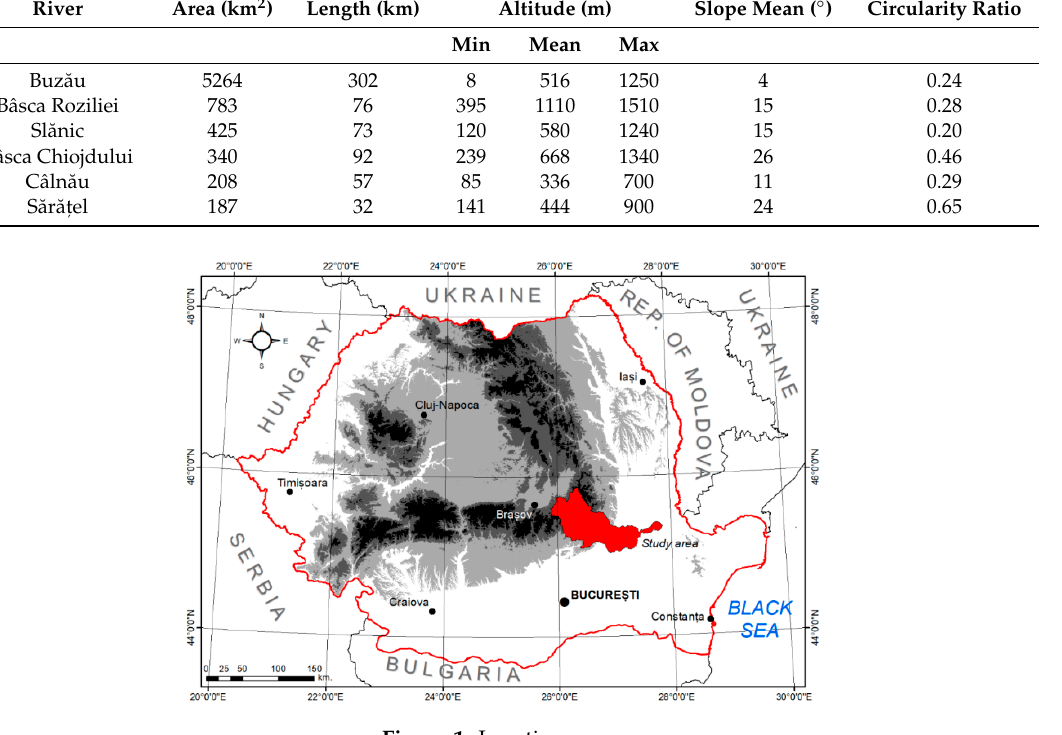
Figure 1. Location map.